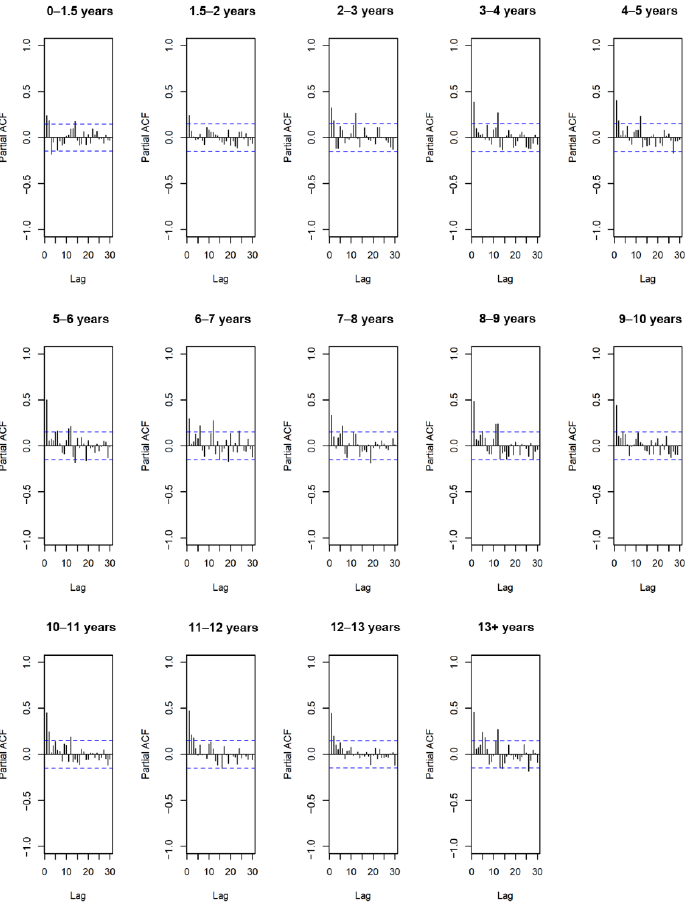
Figure A1. The partial autocorrelation functions of residuals from preliminary analyses for 14 age groups.